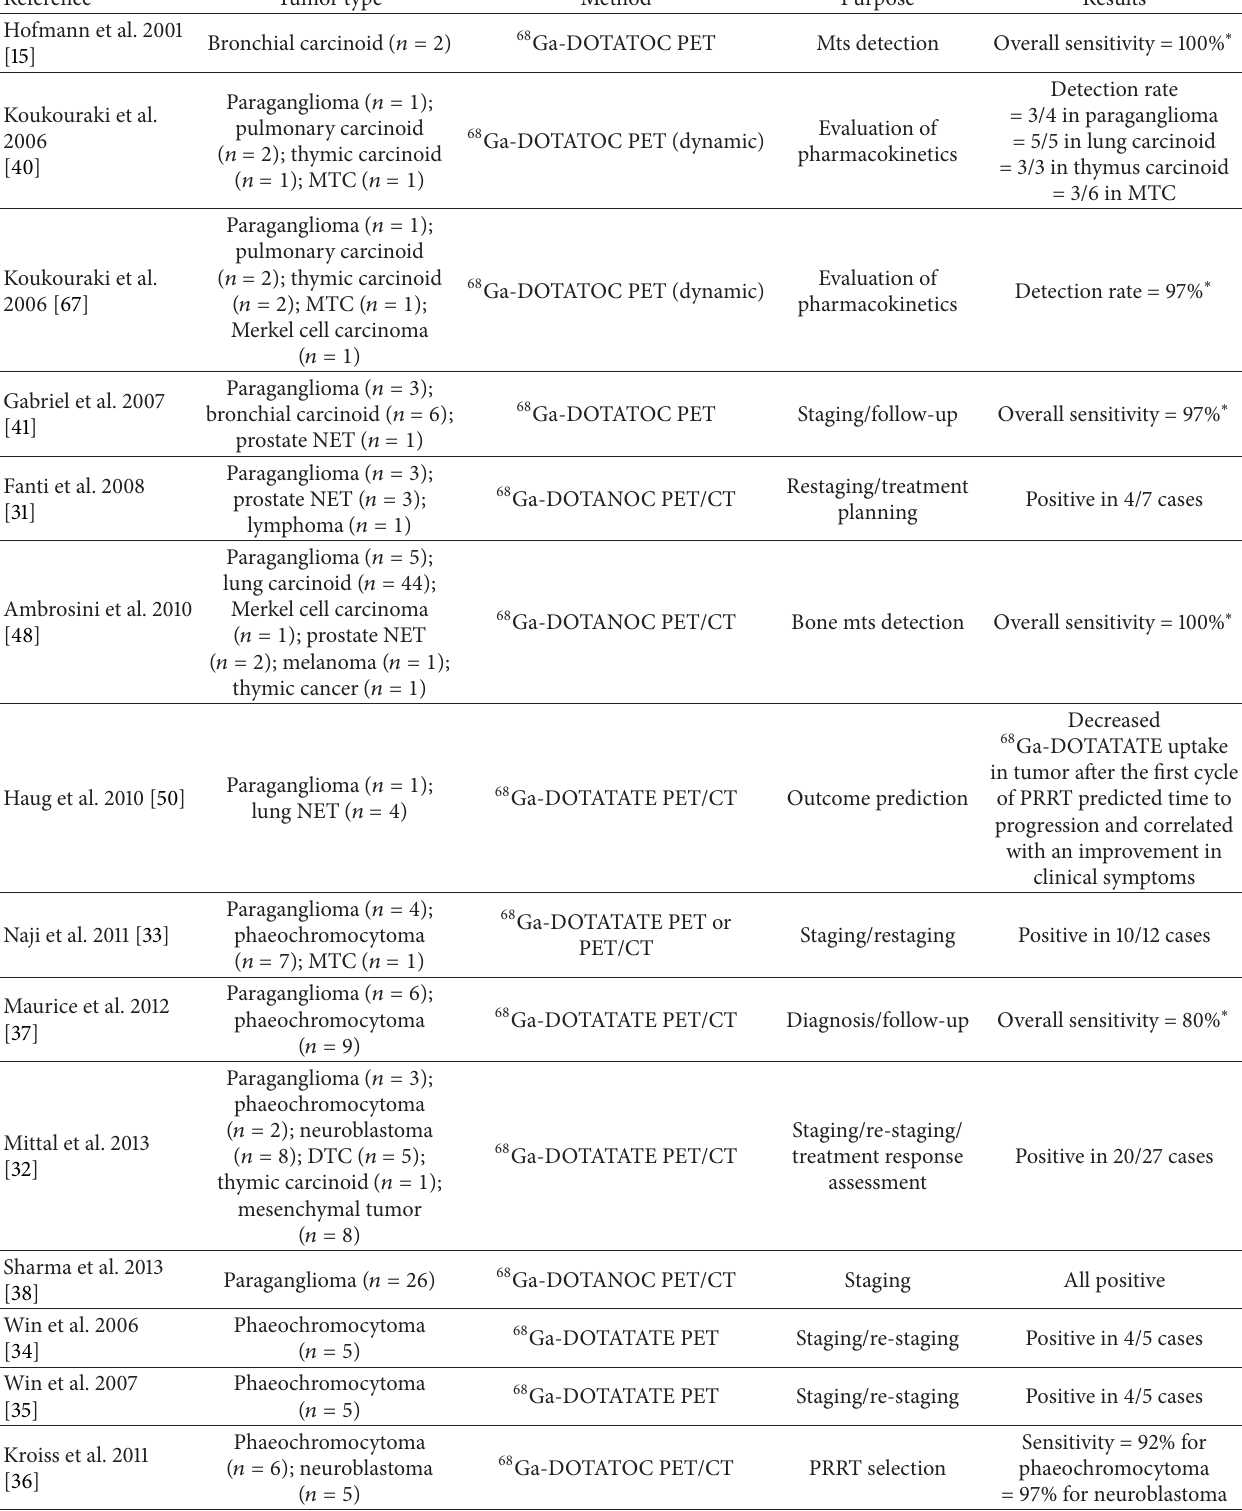
Table 2: Overview of the role of positron emission tomography and positron emission tomography/computed tomography with 68